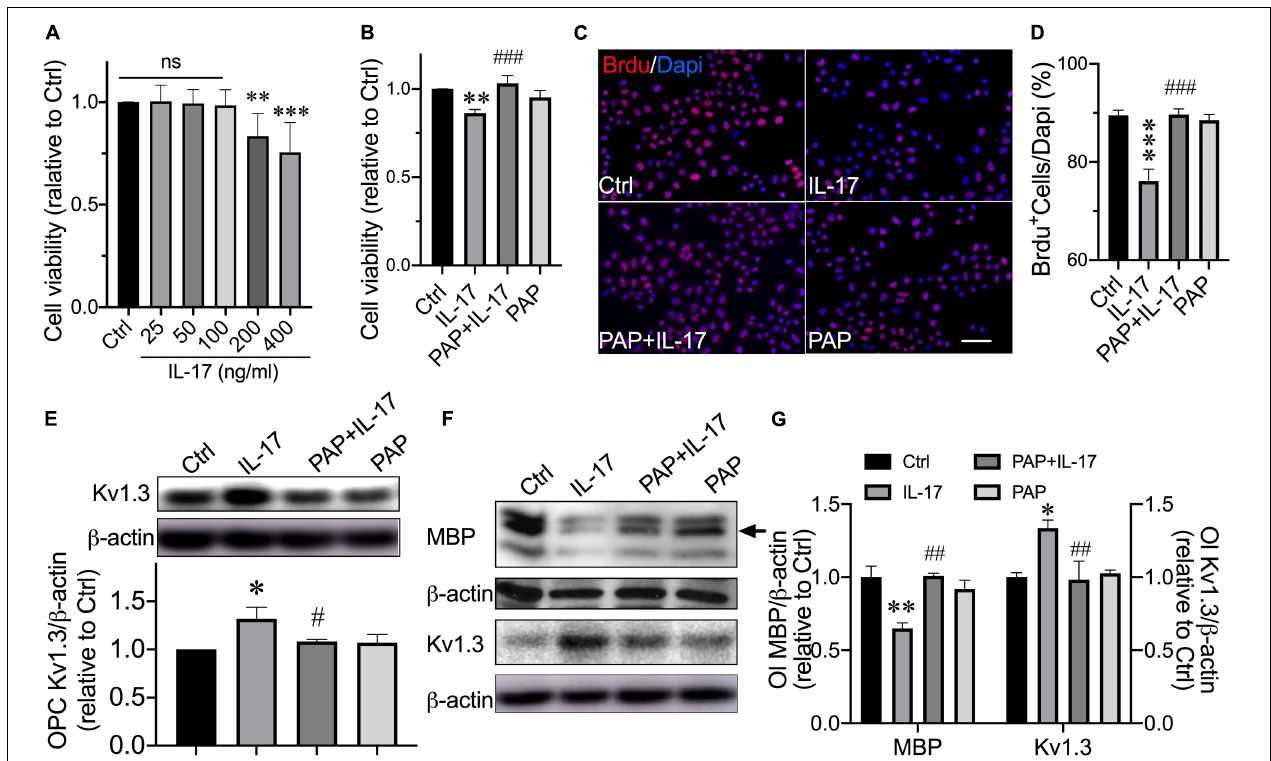
FIGURE 2 | Kv1.3 blockade prevented OPCs from IL-17–induced inhibition of proliferation and differentiation. OPCs were exposed to IL-17 (200 ng/mL) for 48 h with or without preaddition of PAP (10 nM) for 30 min. (A) The dose of IL-17 was tittered by MTT assay performed in OPCs ( n = 6). IL-17 significantly reduced cell viability at a concentration of 200 ng/mL and further reduced at the concentration of 400 ng/mL. (B) MTT assay was performed to detect OPC viability ( n = 7). PAP pretreatment counteracted the loss of cell viability induced by IL-17. (C) OPCs were treated with IL-17 with or without PAP in the presence of BrdU (10 µ M) for 48 h. Representative images of merged BrdU immunofluorescence staining (red) and DAPI (blue) are shown. Scale bar = 20 µ m. The average percentage of BrdU + cells from five independent experiments are summarized in (D) There were 10 randomly selected visual fields counted for each group from three independent experimental treatments. IL-17–induced reduction of BrdU + cells was attenuated by PAP. (E) Western blot analysis of Kv1.3 expression in OPCs. Band densitometry data are shown in the bar graph (below) ( n = 4). IL-17 treatment for 48 h elevated the Kv1.3 protein expression in OPCs, whereas the PAP attenuated this elevation. For experiments conducted with Ols in (F,G) , Ols were exposed to IL-17 (200 ng/mL) with or without prior addition of PAP (10 nM) for 30 min during the differentiation culture in OPCDM for 6 days. (F , G) Representative images and statistical analyses of MBP and Kv1.3 expression in mature Ols of Western blot ( n = 3). The band marked by the arrow is a protein band with a size of 18.5 kDa. Pretreatment with PAP for 30 min counteracted the decrease in MBP and increase in Kv1.3 protein expression in Ols induced by IL-17. ∗ P < 0.05 vs. control, ∗∗ P < 0.01 vs. control, ∗∗∗ P < 0.001 vs. control. # P < 0.05 vs. IL-17, ## P < 0.01 vs. IL-17, ### P < 0.001 vs.